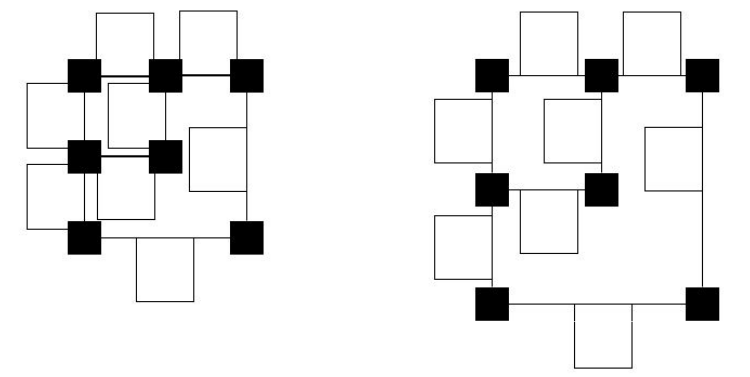
Figure 23. A sample orthogonal drawing where we have to increase the height and the width of the drawing in order to resolve label overlaps.